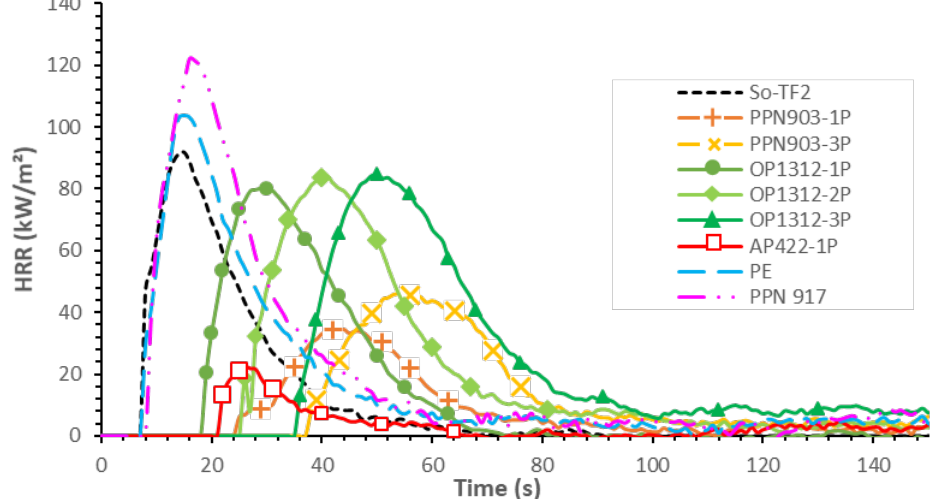
Figure 3. HRR curves of SORIC flame retarded with different additives.